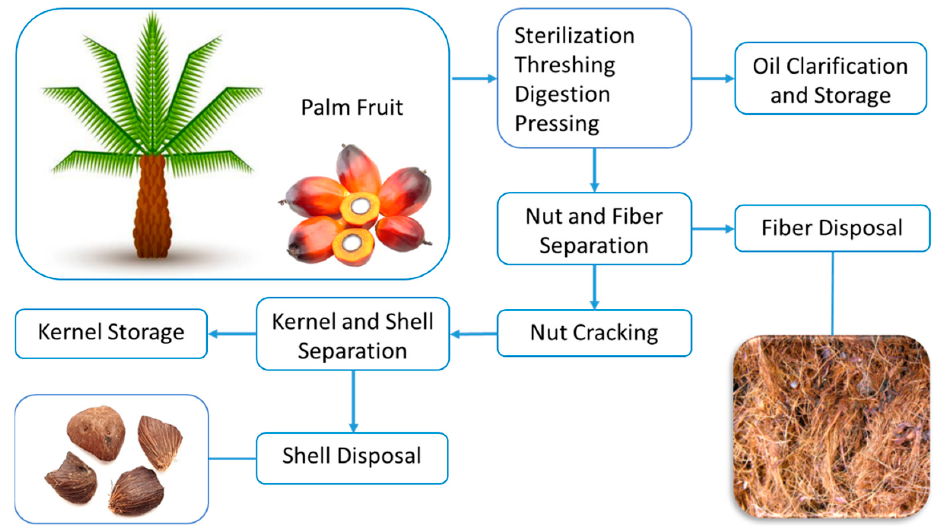
Figure 1. The OPS extraction from the palm fruit.